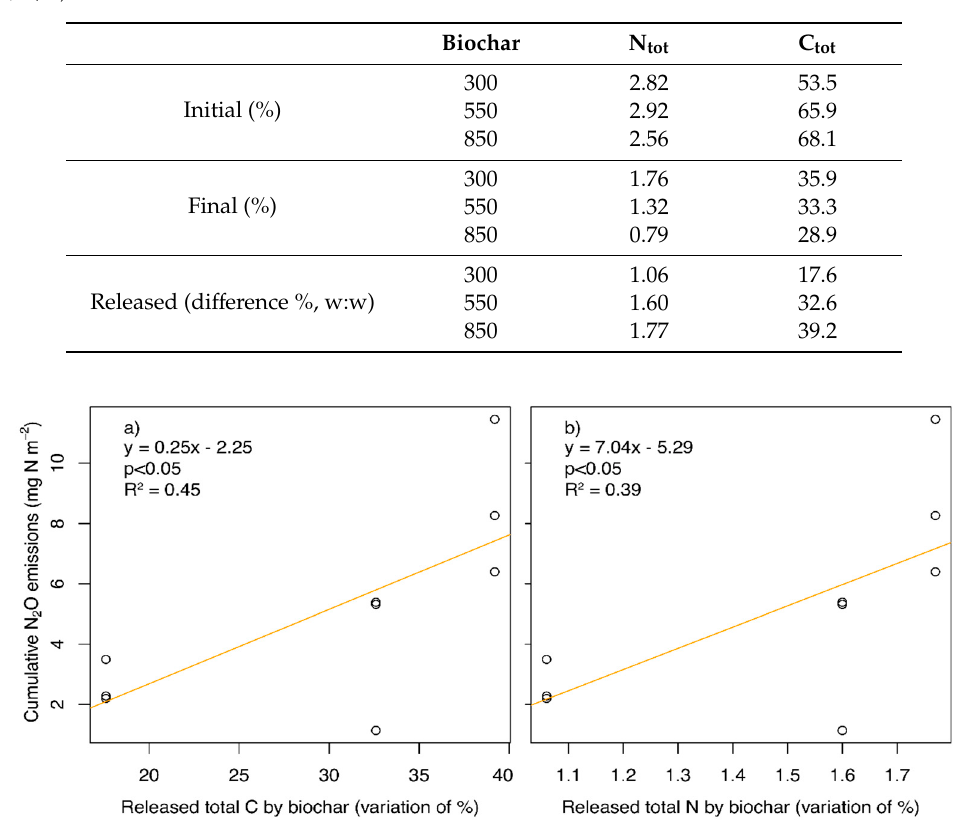
Table 6. Initial and final content (%) of N tot and C tot , in biochar at the beginning and at the end of the experiment, and C tot and N tot released by the biochar during the experiment, proportion of total (%, w / w ).